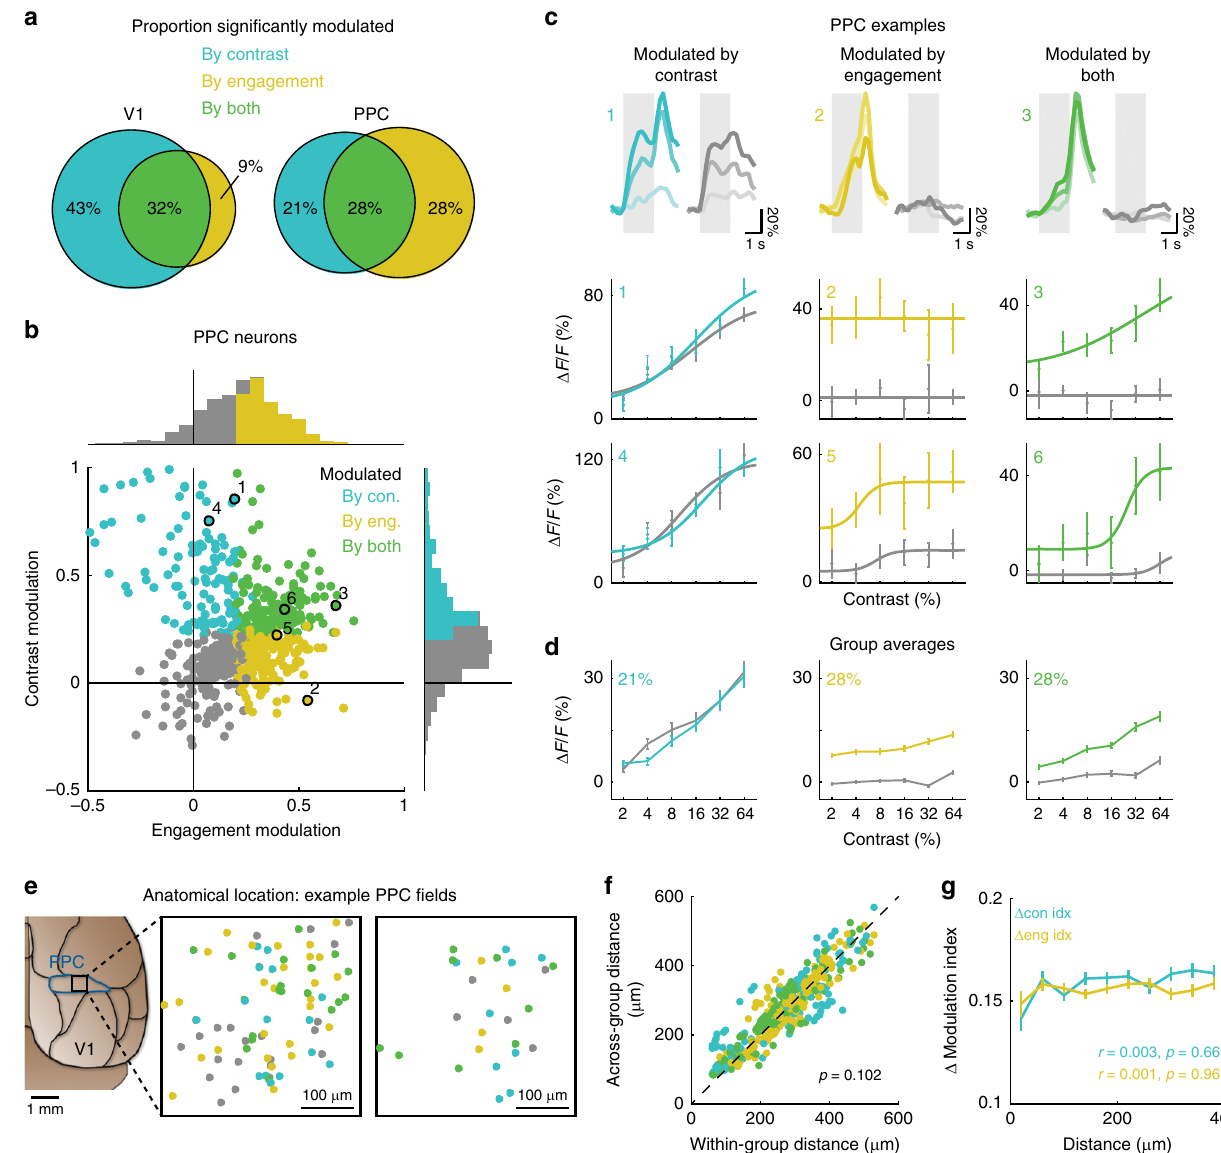
Fig 6 PPC neurons are heterogeneous in their sensitivity to contrast and engagement. a Venn diagrams indicating proportions of target-preferring neurons in V1 and PPC with signi fi cantly positive modulation by contrast alone (cyan), engagement alone (yellow), or both contrast and engagement (green). b Scatter plot and histograms of contrast modulation vs. engagement modulation for all target-preferring PPC neurons ( n = 611) imaged during the variable contrast task. Colored bars in histograms (same as Fig. 5f, h) indicate neurons with signi fi cantly positive modulation by contrast (cyan) or engagement (yellow). Colored dots on scatter plot demarcate neurons with signi fi cantly positive modulation by contrast alone (cyan), engagement alone (yellow), or both contrast and engagement (green). Individual examples in c are marked with the corresponding number. c Trial-averaged responses (top row) and contrast-response functions (middle and bottom rows) of example PPC neurons that were signi fi cantly modulated by contrast (left column), engagement (middle column), or both (right column). Contrast-response functions were computed from responses during the stimulus-period (gray shaded region in top row). Modulation index values for each example can be found by referring to b . Error bars indicate SEM across trials. d Group-averaged contrast- response functions. Percentages indicates proportion of PPC neurons within each group. Error bars indicate SEM across cells. e Left, approximate location of imaging fi elds within PPC (blue). Schematic modi fi ed from the Allen Mouse Brain Atlas (http://mouse.brain-map.org/static/brainexplorer). Right, relative spatial location of neurons with modulation by contrast, engagement, or both, in two example imaging sessions. Spatial locations of cells from 4 planes are collapsed into one. Scale bar, 100 µ m. f Average within-group and across-group distances for each cell, colored by group. No signi fi cant difference was found for any individual group or for the whole population ( p = 0.102, clustered Wilcoxon signed-rank test). g Difference in engagement (yellow) and contrast (cyan) modulation indices as a function of distance between cells. Error bars indicate SEM across cells. Distances beyond 400 µ m are not shown. No signi fi cant correlation between modulation index and distance was identi fi ed the same neurons across imaging sessions using a semi- Many neurons in V1 that were selective to a particular stimulus automated procedure 25 (see "Methods" section for details). We analyzed the trial selectivity of individual neurons that had remained selective to the same stimulus after reversal, whether signi fi cant responses both before and after reversal (V1, n = 488 Stimulus A or Stimulus B (Fig. 7c). By contrast, many PPC